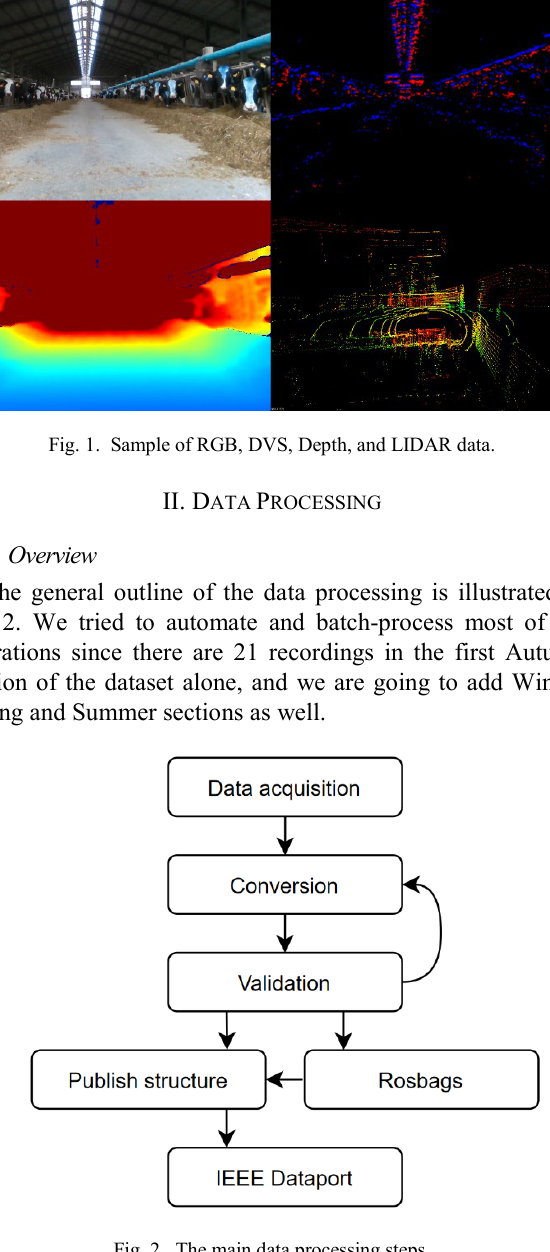
Fig. 2. The main data processing steps.